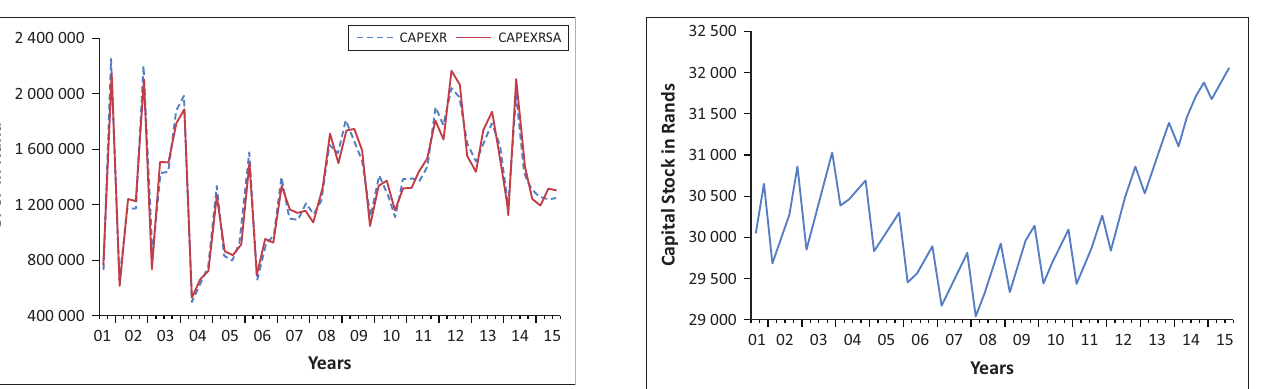
FIGURE 7: Seasonal adjusted fixed provincial government capital stock per skill adjusted labour supply (R’ 2010 prices). .03